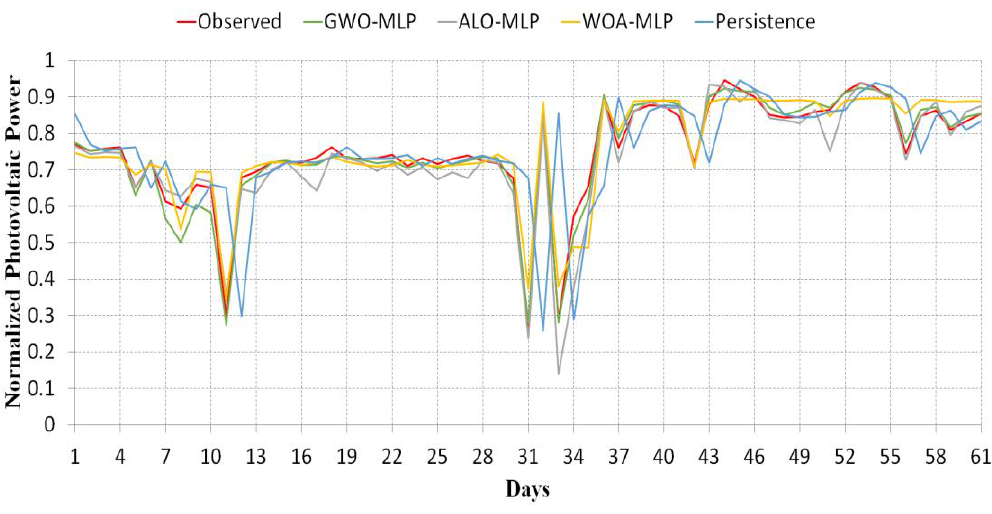
Figure 12. The predicted photovoltaic power values of GWO-MLP, ALO-MLP, WOA-MLP hybrid models and persistence reference model.